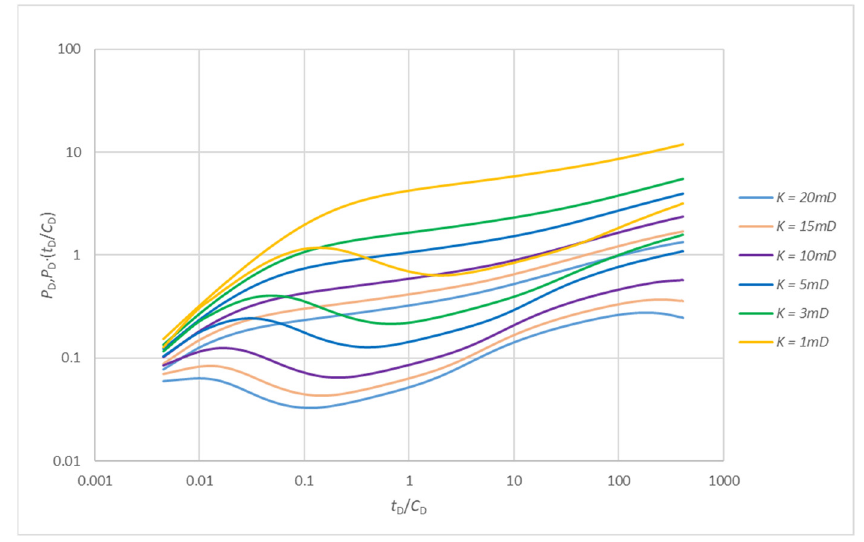
Figure 11. Well test curves of different formation permeability.